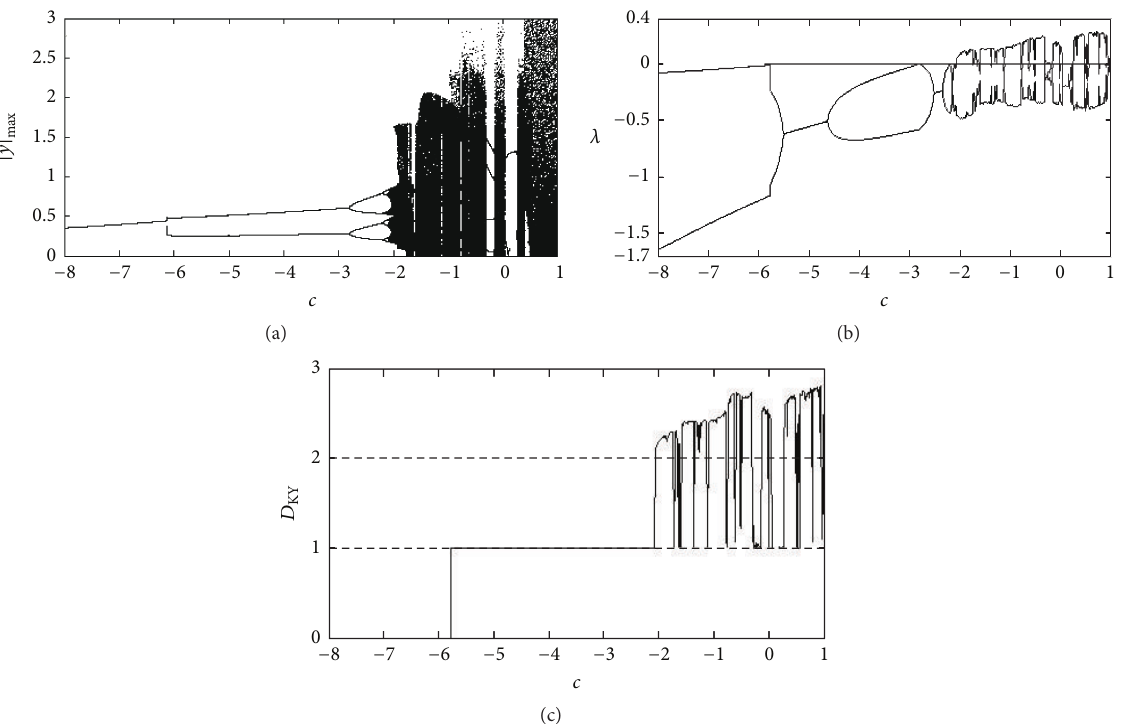
Figure 1: (a) Bifurcation diagram for specific values set (𝑎 = 0.4, 𝑏 = 3) versus 𝑐 , (b) Lyapunov-exponent spectrum against 𝑐 corresponding to the bifurcation diagram of (a), and (c) Kaplan-Yorke dimension versus the control parameter 𝑐 corresponding to the bifurcation diagram of